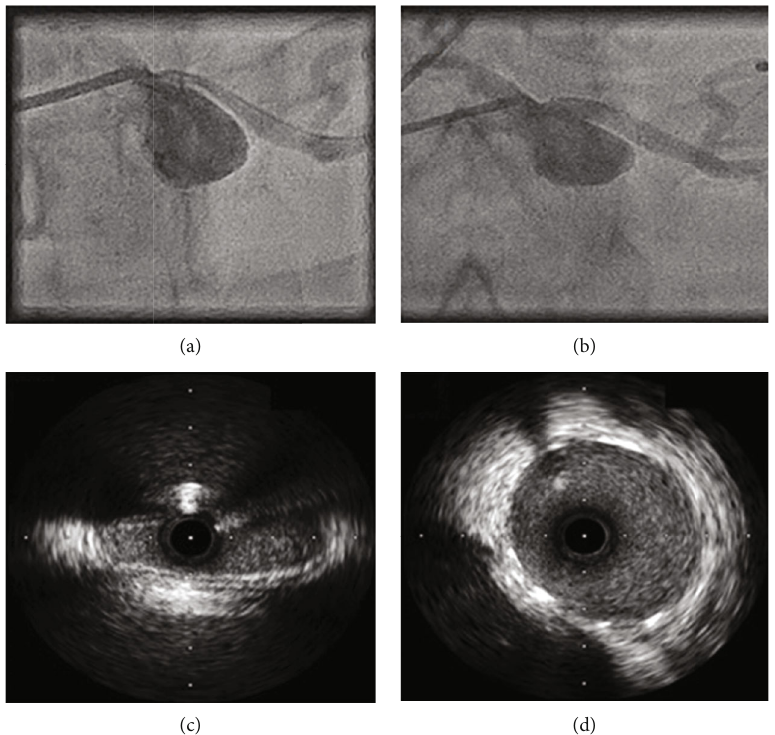
Figure 4: (a) Angiography demonstrating severe ostial LMCA stenosis despite intracoronary nitrate and disengaged guide catheter; (b) angiography following deployment of 5 × 20 mm stent; (c) baseline IVUS with a slit-like lumen of LMCA and distinct lack of atheroma; (d) well-apposed coronary stent and near-circular lumen of